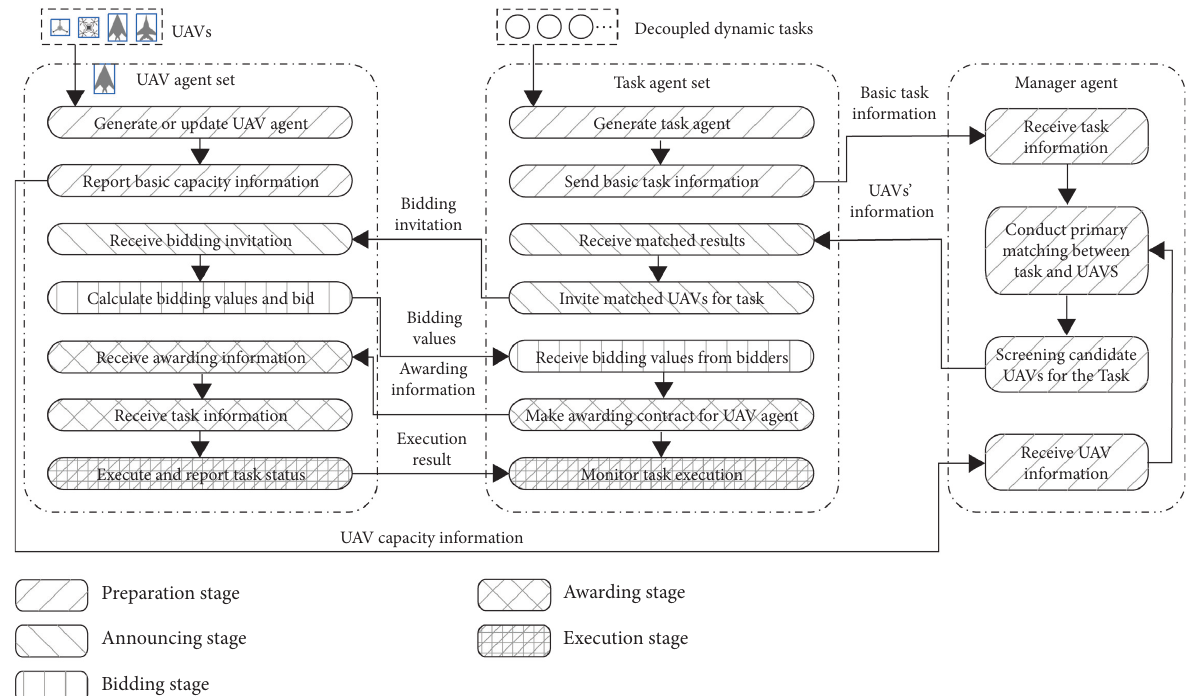
Figure 2: The basic activities and interactions of agents.